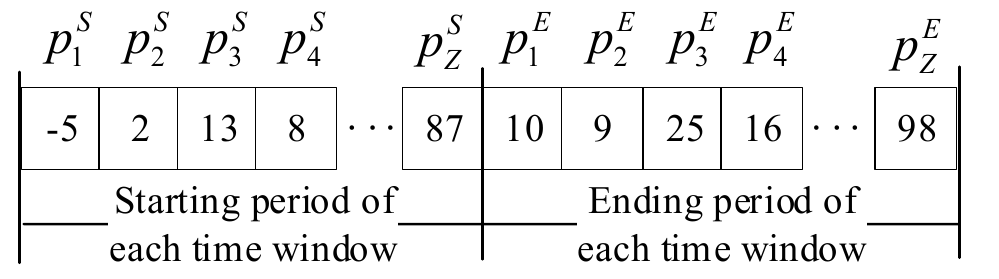
Figure 5. Chromosome structure.